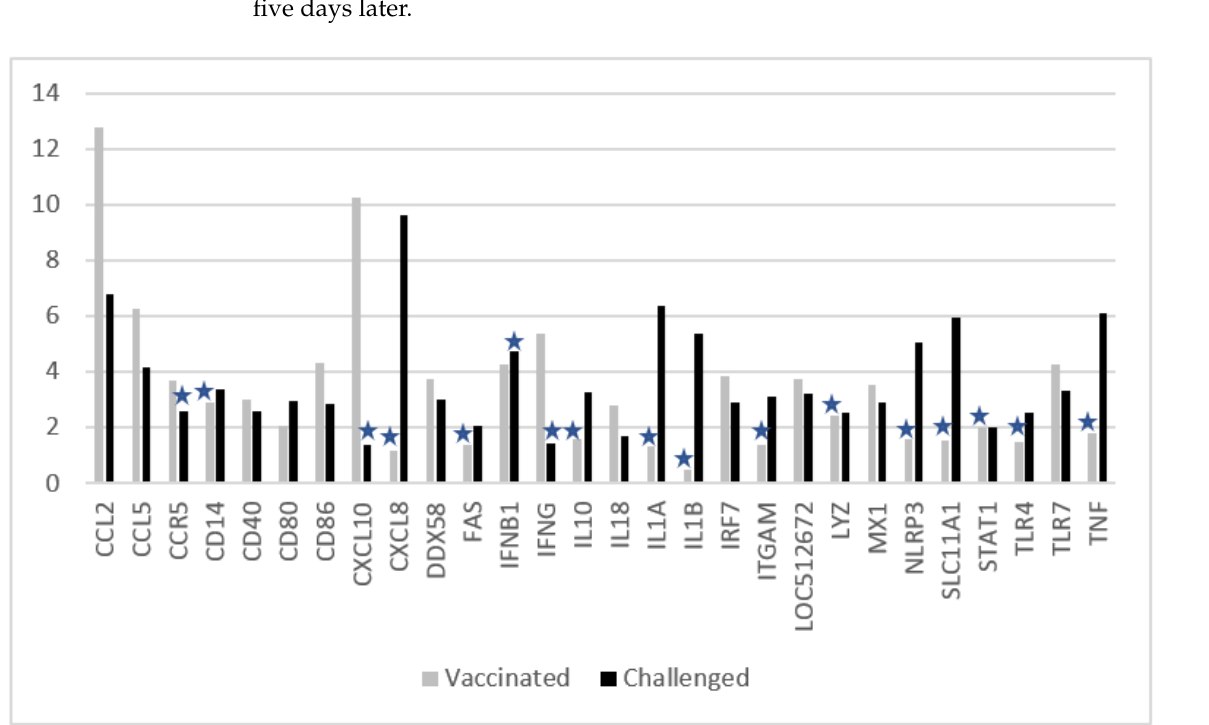
Figure 3. Comparison of gene expression (fold-change on Y -axis) of vaccinated- versus nonvaccinated-challenged animals. Genes are shown which had significant changes in Ct values five days after vaccination or five days after challenge (see materials and methods). Asterisks indicate non-significant changes according to the arbitrary criteria described in the materials and methods section.